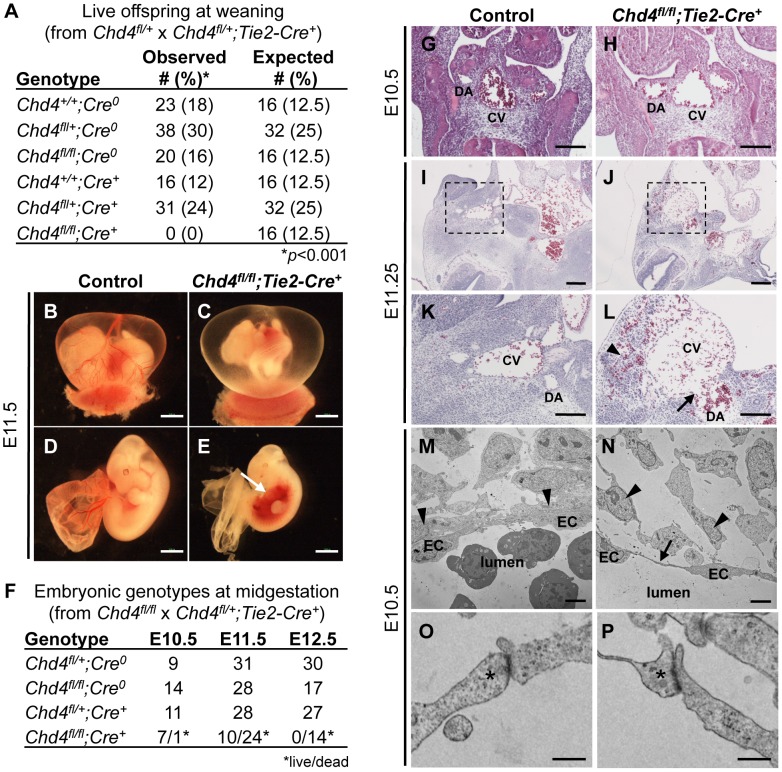

Chd4fl/fl;Tie2-Cre+ embryos undergo vascular rupture by E11.25.(A) Chd4fl/+ females were mated with Chd4fl/+;Tie2-Cre+ males, and live progeny from 22 litters were genotyped and scored at weaning. No live Chd4fl/fl;Tie2-Cre+ mice were recovered [χ2(5dof): p<0.001]. (B–E) Gross images of E11.5 littermate control (B,D) and Chd4fl/fl;Tie2-Cre+ (C,E) embryos. Arrow in panel E indicates massive hemorrhage within the ventral trunk region of a Chd4fl/fl;Tie2-Cre+ embryo. (F) Chd4fl/fl females were mated with Chd4fl/+;Tie2-Cre+ males, and dissections were performed on E10.5–12.5 embryos. Dead embryos were characterized by absence of heartbeat and onset of necrosis. No surviving Chd4fl/fl;Tie2-Cre+ embryos were found at E12.5 [χ2(3dof): p<0.01]. (G–L) Hematoxylin and eosin (H&E) staining of E10.5 (G,H) or E11.2±5 (I–L) littermate control (G,I,K) and Chd4fl/fl;Tie2-Cre+ (H,J,L) embryos. Boxed regions in panels I and J are shown at higher magnification in panels K and L respectively. Arrow in panel L reveals site of vascular rupture between the mutant dorsal aorta and cardinal vein; arrowhead indicates blood in extravascular tissues. DA, dorsal aorta; CV, cardinal vein. (M–P) Transmission electron micrographs from vessel walls of E10.5 littermate control (M,O) and Chd4fl/fl;Tie2-Cre+ (N,P) embryos. Arrowheads in panels M and N indicate smooth muscle cells adjacent to endothelial cells (ECs). Arrow in panel N points to a long, thin EC extension. (O,P) Endothelial cell junctions (*) are intact in both control and mutant sections. Scale bars: 1 mm (B–E); 100 µm (G–L); 2 µm (M,N); 500 nm (O,P).